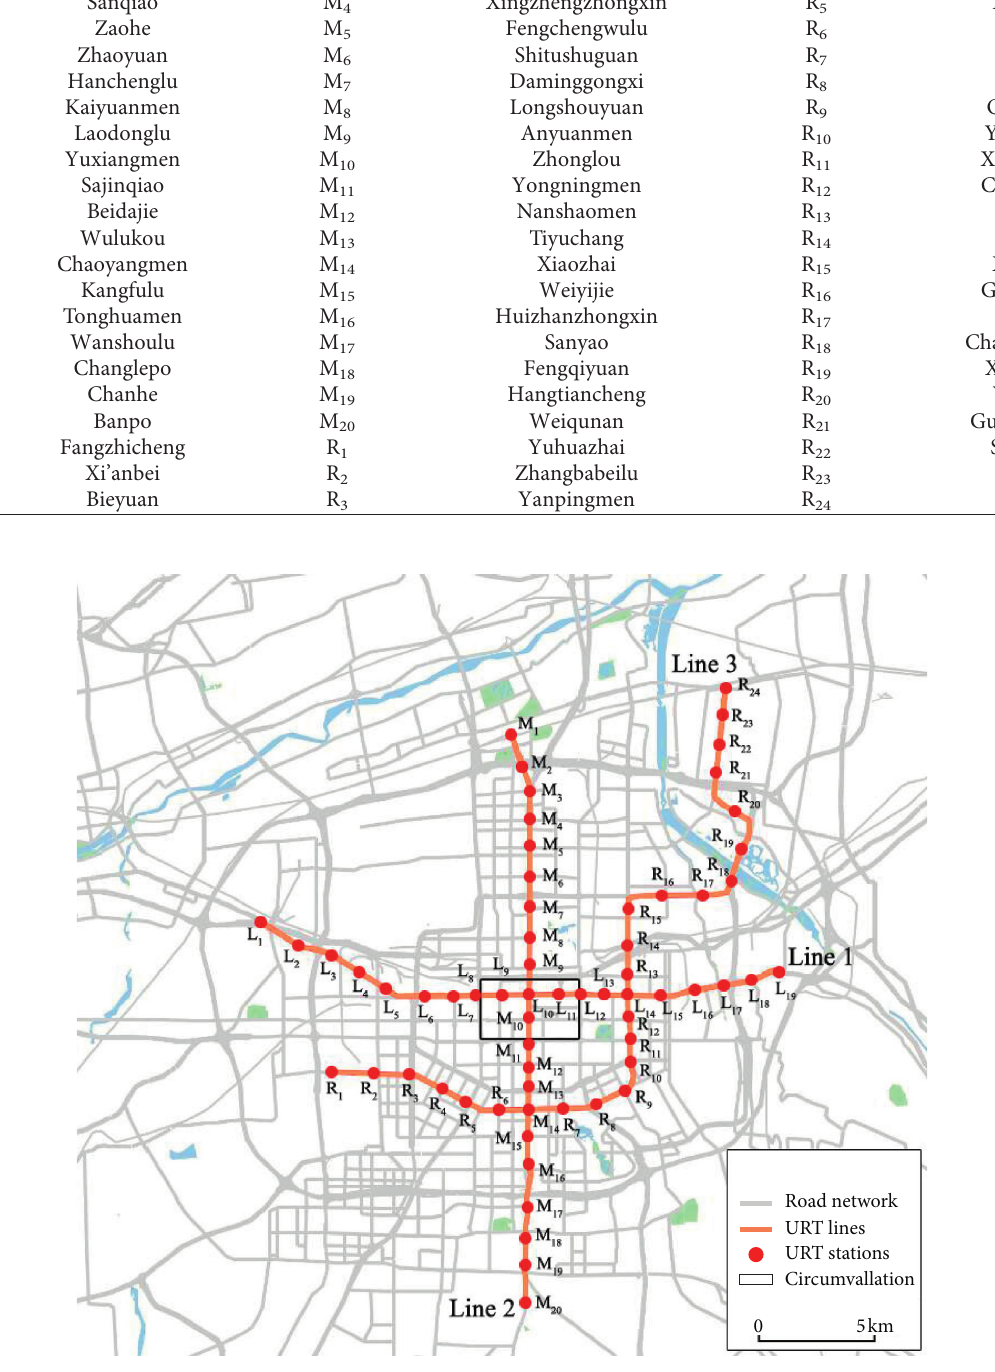
Figure 2: Urban rail transit network of Xi’an,